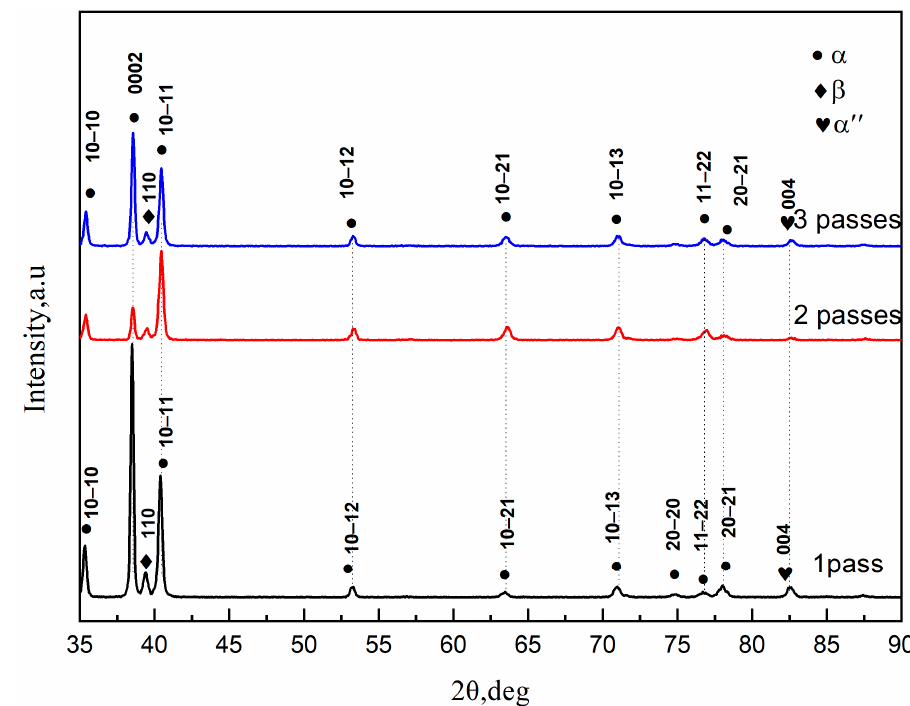
Figure 4. XRD pattern of TC4 alloy during each pass processed by MDIF.